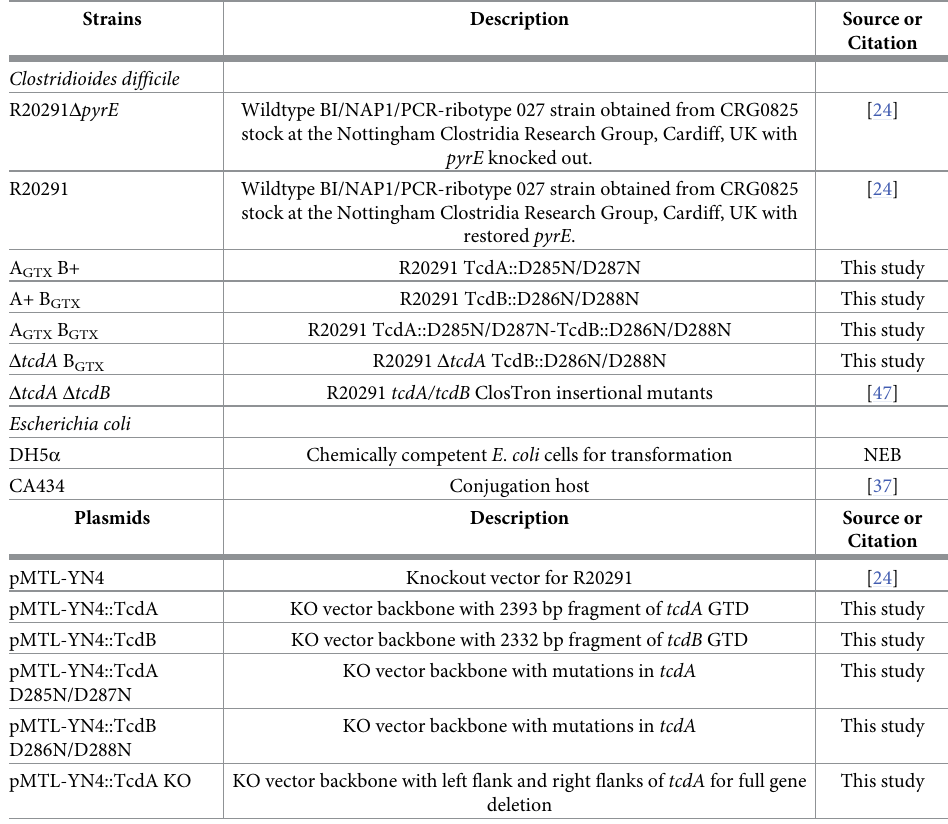
Table 1. Strains and plasmids used in this